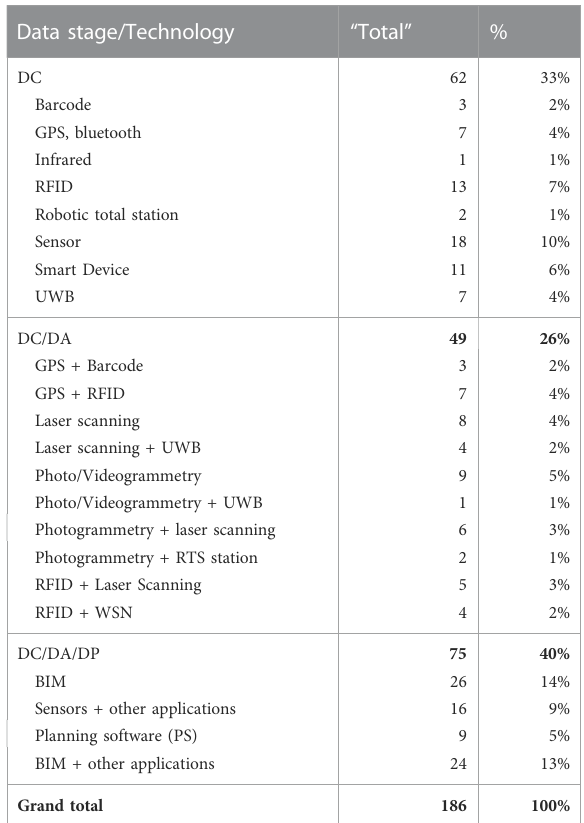
TABLE 4 Technologies distribution among data